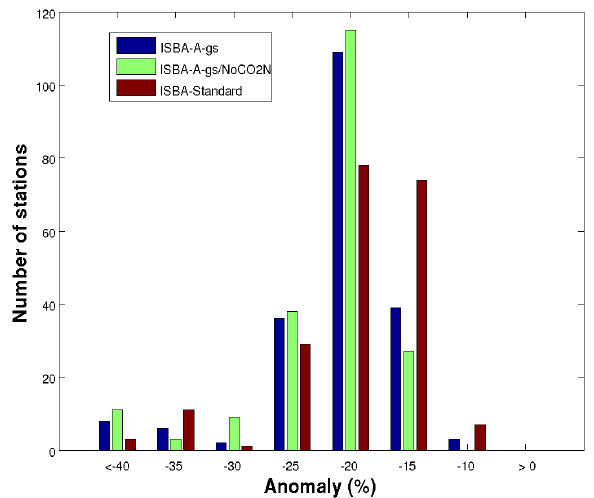
Fig. 10. Histogram of the number of stations in each class of annual anomaly of discharge between the future climate and the present climate according to ISBA-A-gs, ISBA-A-gs/NoCO2N, and ISBA- Standard.